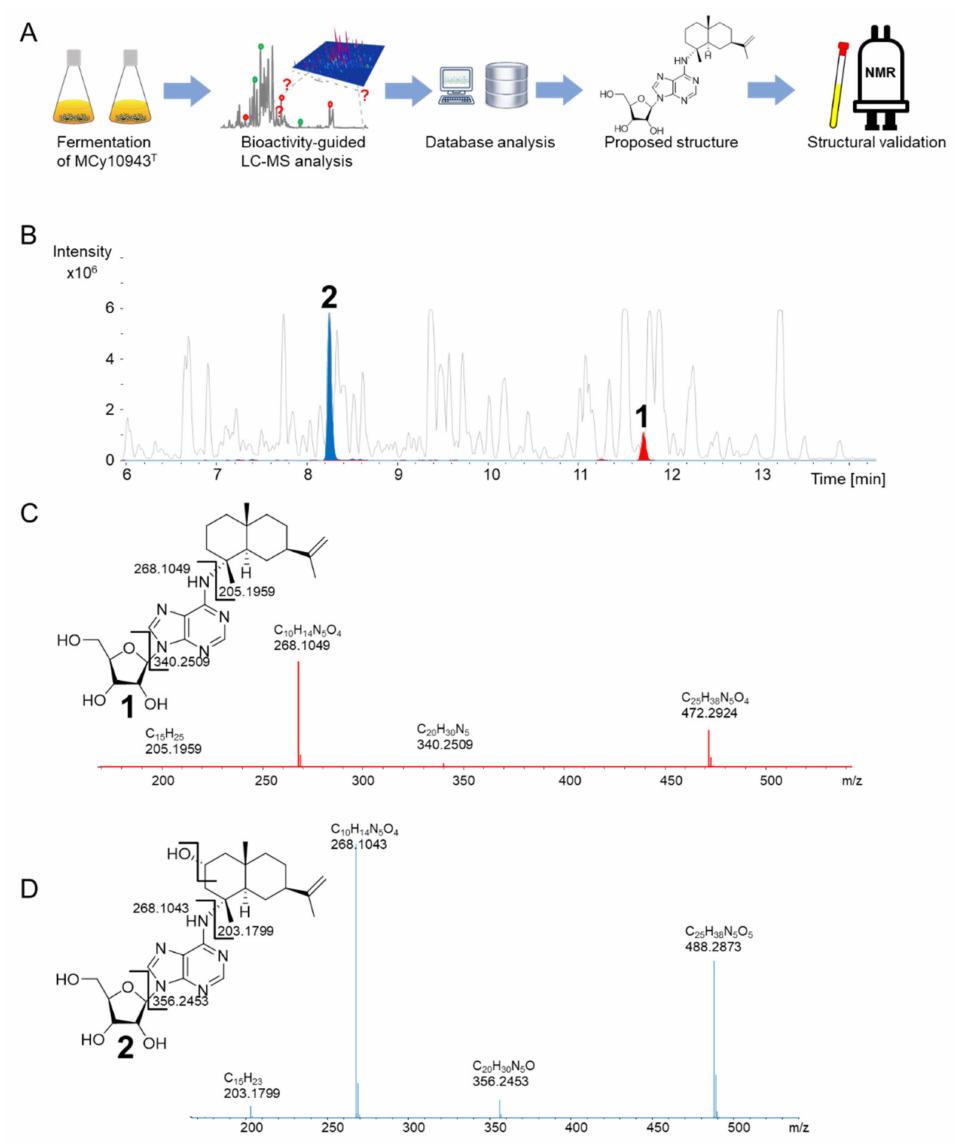
Figure 2. ( A ) Workflow of secondary metabolite screening in MCy10943 T , resulting in the independent re-isolation of sorangiadenosine ( 1 ) and the discovery of 2-hydroxysorangiadenosine ( 2 ). ( B ) High-performance liquid chromatography–mass spectrometry base peak chromatogram (HPLC-MS BPC) (grey) and extracted ion chromatogram (EIC) of 1 ([M + H] + 472.2923 m / z , red) and 2 ([M + H] + 488.2873 m / z , blue) from MCy10943 T crude extracts. Fragmentation of sorangiadenosine ( C ) and 2-hydroxysorangiadenosine ( D ) in MS 2